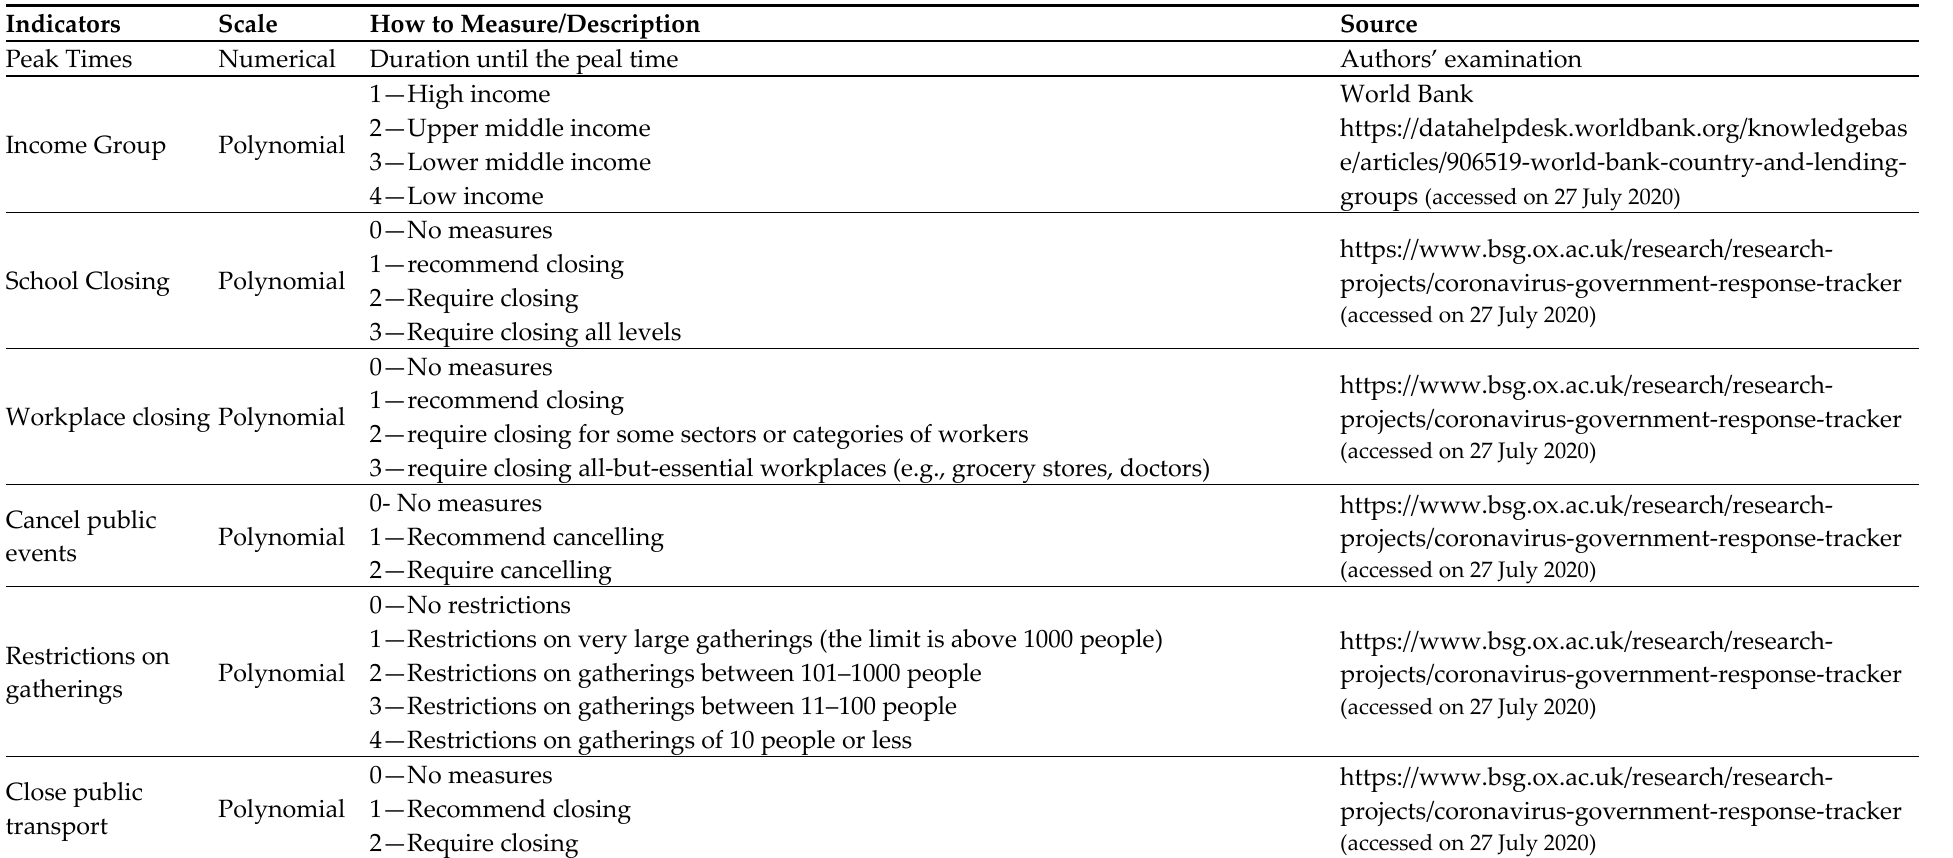
Table A1. Variable Descriptions and Sources